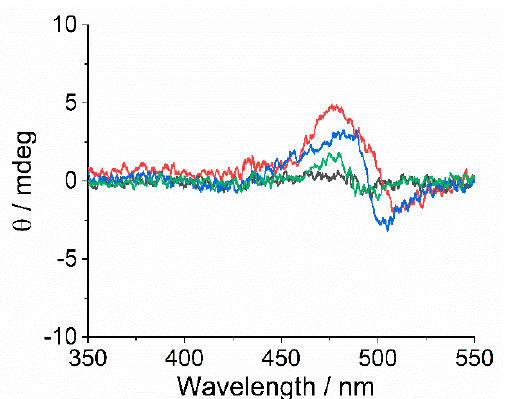
Figure 9. CD spectra of the samples after complete aggregation of TPPS 4 for the various metal derivatives MT 4 (AuT 4 (black), CoT 4 (red), MnT 4 (blue), ZnT 4 (green). (Experimental conditions: [TPPS 4 ] = 3 μ M; [MT 4 ] = 1.5 μ M; [HCl] = 0.00158 M, T = 298 K).